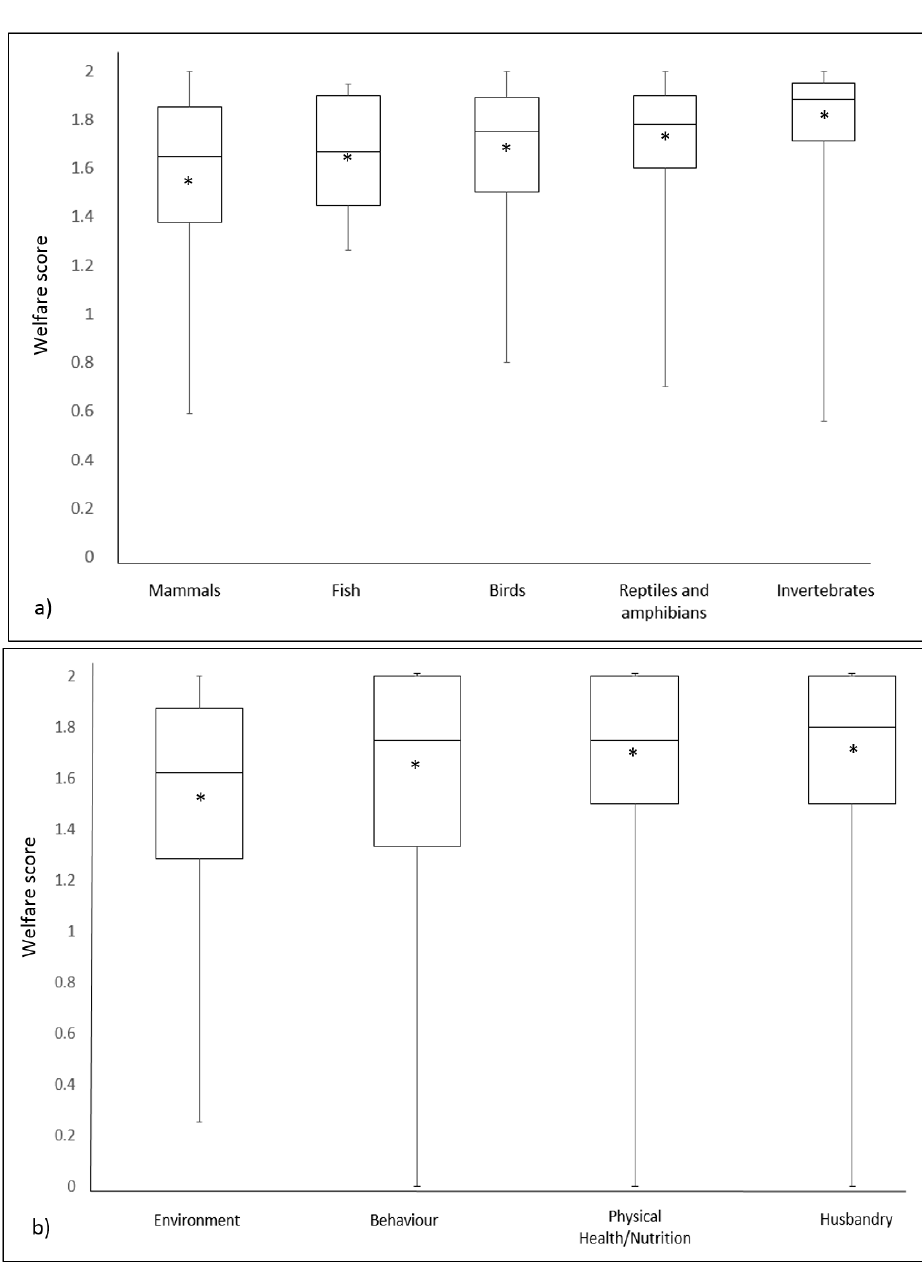
Figure 2. Box plots showing median welfare risk scores, upper, and lower quartiles, the maximum and minimum range and mean welfare risk scores (*) across all three zoos by taxon ( a ) and welfare domain ( b ). The higher the welfare score, the lower the risk